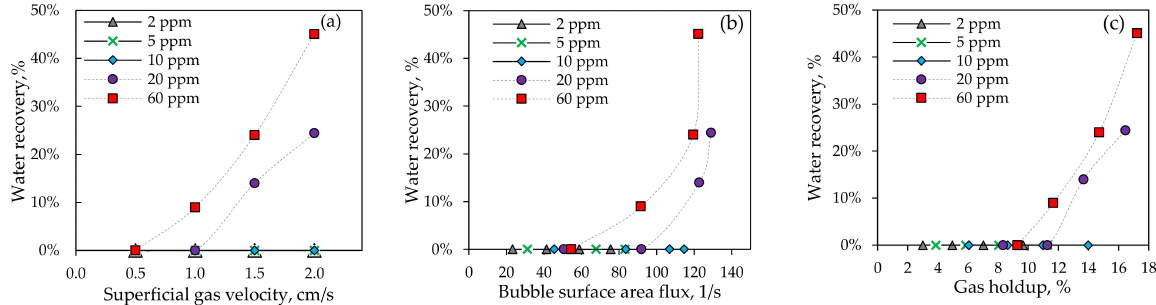
Figure 8. Water recovery as a function of ( a ) superficial gas velocity, ( b ) bubble surface area flux, and ( c ) gas holdup.